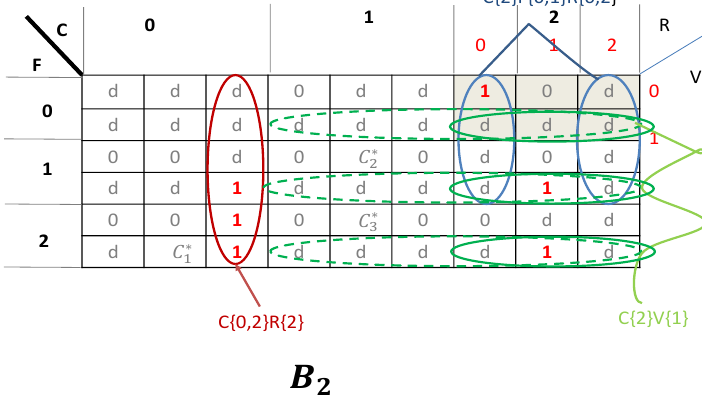
Fig. 5. A multi-valued-Karnaugh-map representation of 𝑩 (implementation of party bans), a translation 𝟐 of Table 4 in Hartmann and Kemmerzell (2010), with loops covering the prime implicants of the asserted { } , assuming C part 𝑩 1 * = C 2 * = C 3 * = 𝟐𝒍